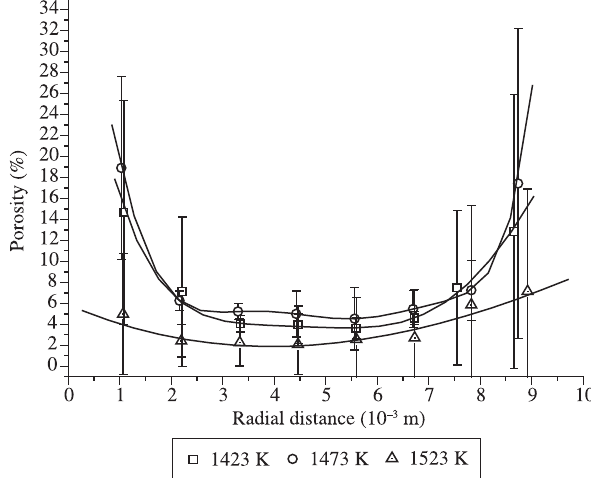
preto).* ASSIM QUE INICIAR A PRODUÇÃO, CONVERTER IMAGEM EM "GRAY SCALE"